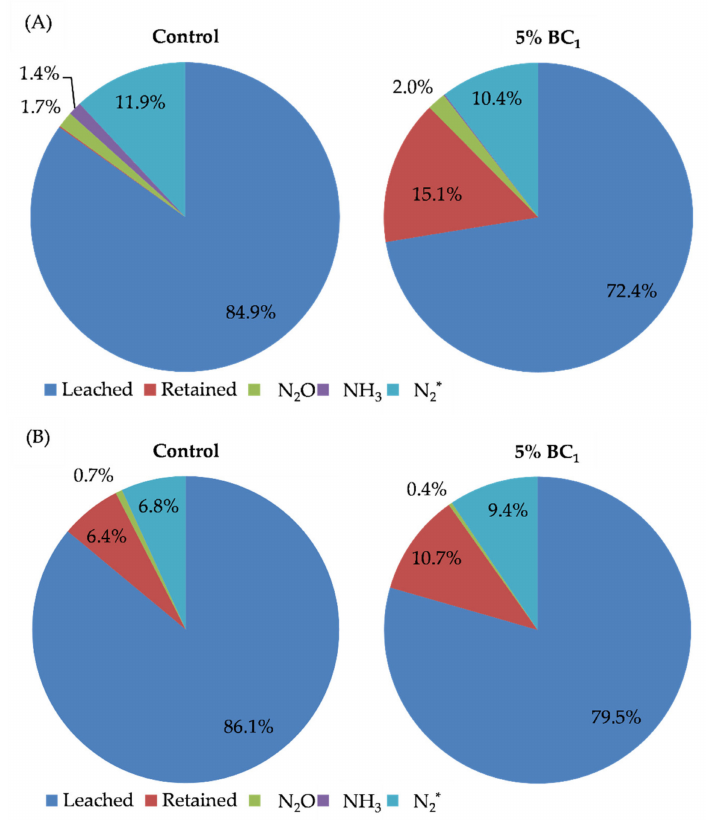
Figure 4. Nitrogen mass balance for influent N for columns receiving ( A ) NH 4 + -N low (treatment group (3) and ( B ) NH 4 + -N high (treatment group (4) application rates. * Assumed that influent TN unaccounted for in e ffl uent N, retention N, N 2 O, or NH 3 was assumed to be lost as N 2